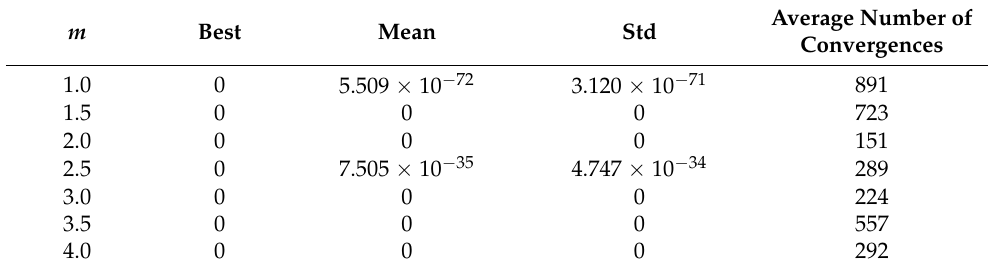
Table 1. Influence of parameter m on